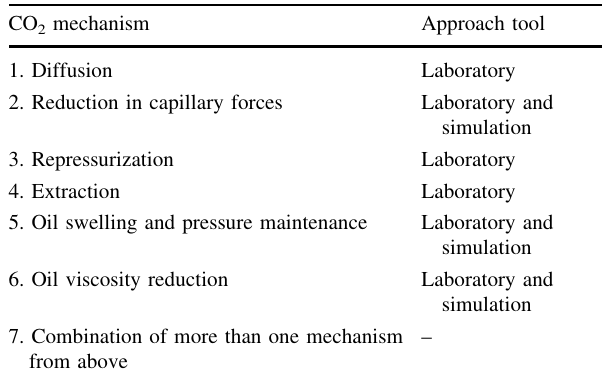
Table 1 Proposed CO 2 EOR mechanisms for improving oil recovery in unconventional reservoirs CO 2